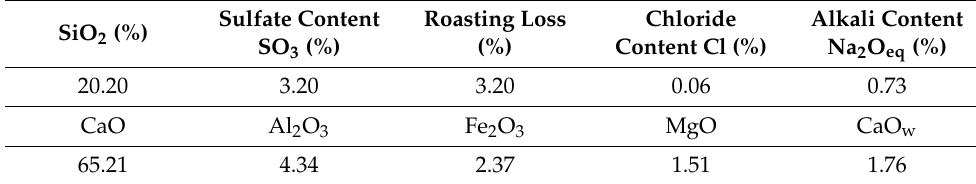
Table 3. Chemical properties of cement CEM I